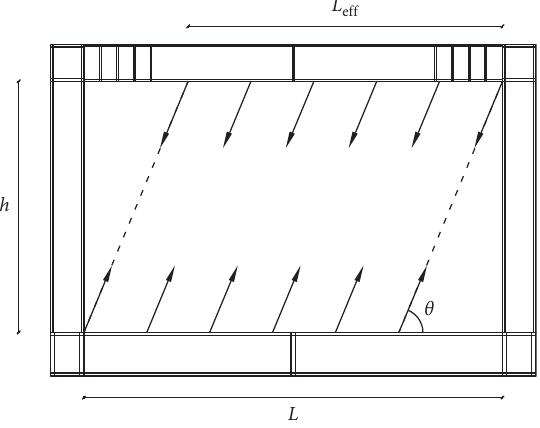
Figure 19: Partial tension field and effective